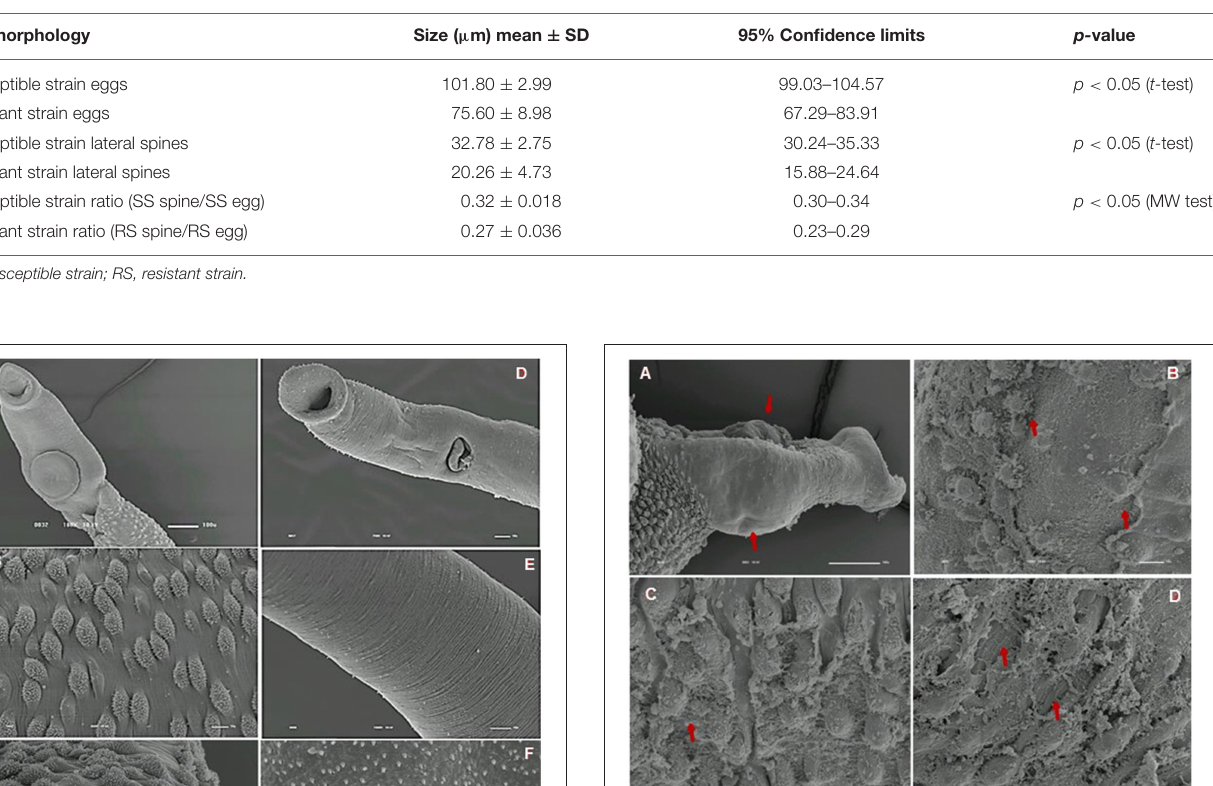
TABLE 1 | Difference in egg morphology (size of the eggs and lateral spine and ratio between them) of S. mansoni resistant and susceptible parasites ( n = 7).